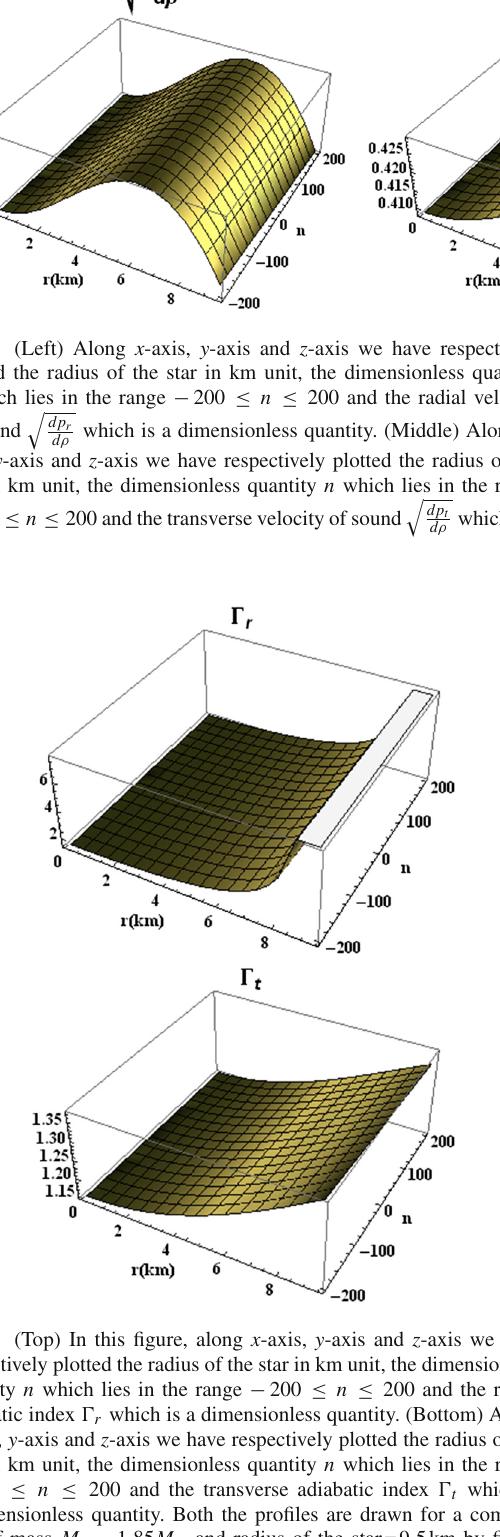
(cid:27) (cid:27) dp t dp r − which d ρ d ρ